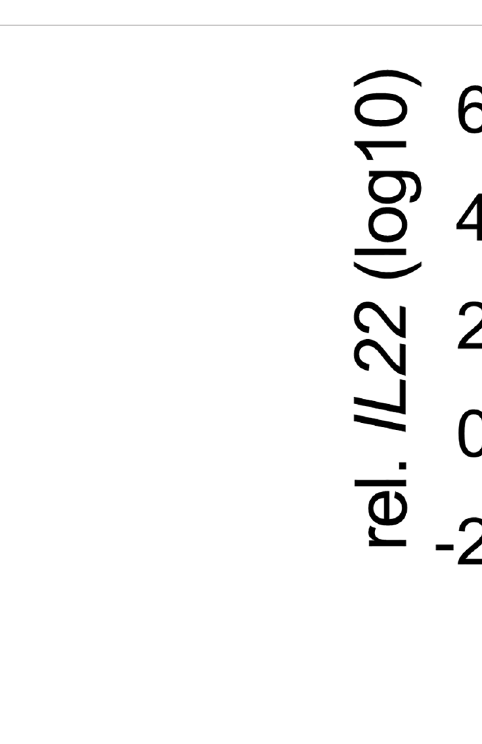
FIGURE 3 | Impact of broad-spectrum antibiotics on IL22 expression. IL22 expression in biopsies derived from the lower GI tract of patients after allogeneic SCT is depicted (no Abx: n = 50, Abx: n = 36). Box plot diagram depicts median, upper, and lower quartiles and whiskers indicate minimal and maximal values. Negative values were set to 0.1. Statistical testing was performed using Mann-Whitney U